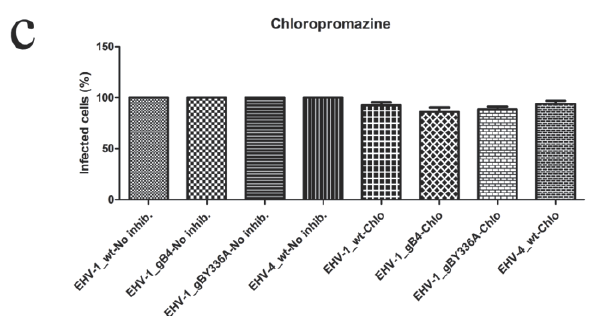
Figure 8. Inhibition of cell entry. Equine dermal (ED) cells were treated with the inhibitors genistein (Gen; a ), dynasore (Dyn; b ) and chlorpromazine (Chlo; c ), as indicated, before infection with parental or recombinant viruses at an MOI of 0.05. At 24 h p.i., cells were washed and the percentage of infected cells was determined by flow cytometry. The percentage of infection of the parental virus was set to 100%. The percentage of infection (eGFP + ) in the absence of inhibitors was set to 100%. All data represent the means ± SD of three independent experiments. Significant decreases ( * ) were only seen for EHV-4_wt in the presence of dynasore and genestein (Kruskal–Wallis one-way analysis of variance; p < 0.05). However, no significant differences in infection rate were seen between parental and recombinant viruses in the different settings (Kruskal–Wallis one-way analysis of variance; p >